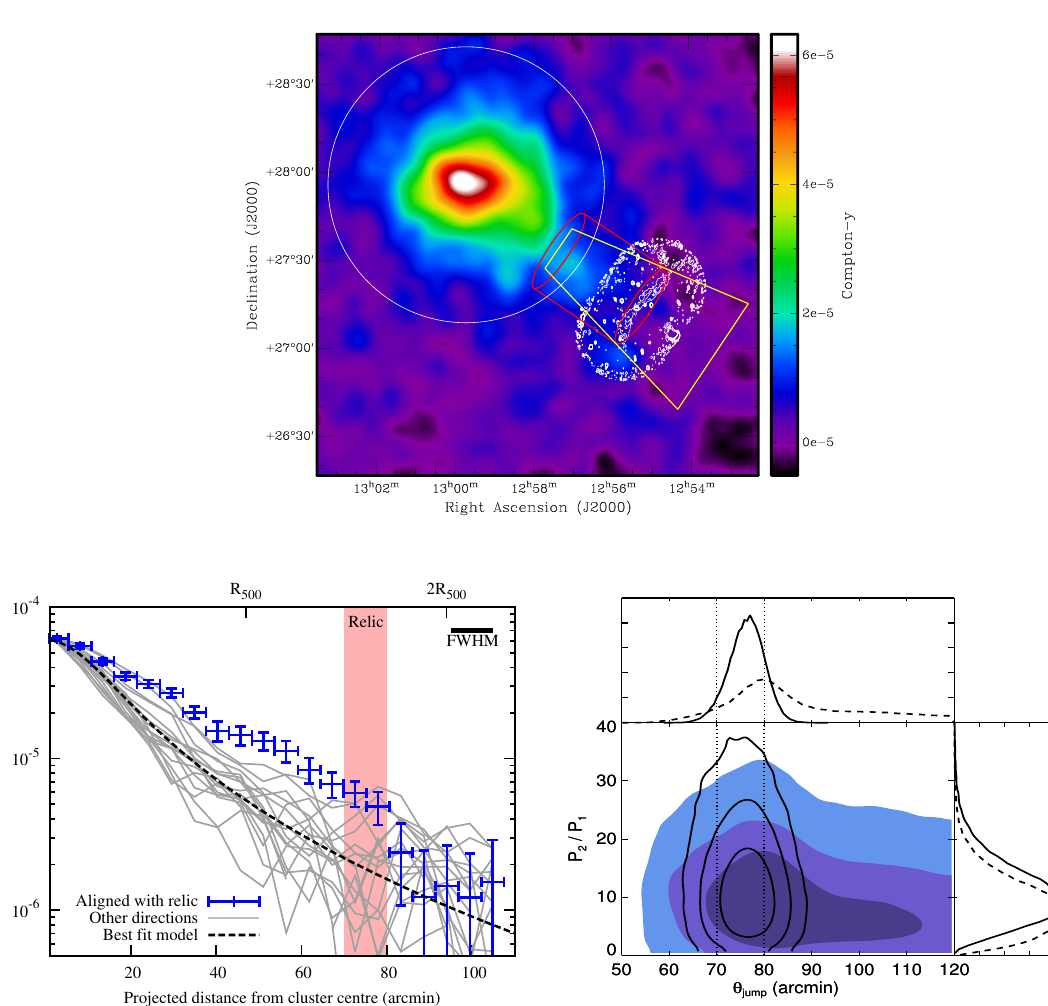
Figure 4. The relic shock in the Coma cluster as detected by the SZ effect (from [15]). Top: Coma Comptonization map derived from a linear combination of the Planck data, overlayed with 2.3 GHz radio contours from the Westerbork Synthesis Radio Telescope (WSRT) array. The thin white circle denotes the R 500 of Coma, and the conical sector used for profile fitting and the cylindrical shock model geometry are shown respectively in yellow and red. Lower left: SZ profile in the direction of the relic shock, shown in blue. Various gray lines denote similar profiles in the other directions, and the dashed line is the best-fit model averaging these other sectors (see [15] for details). Lower Right: Joint likelihood contours for the shock position and the pressure ratio, with (solid lines) and without (dashed lines) having a radio prior on the shock location. FWHM: full width at half